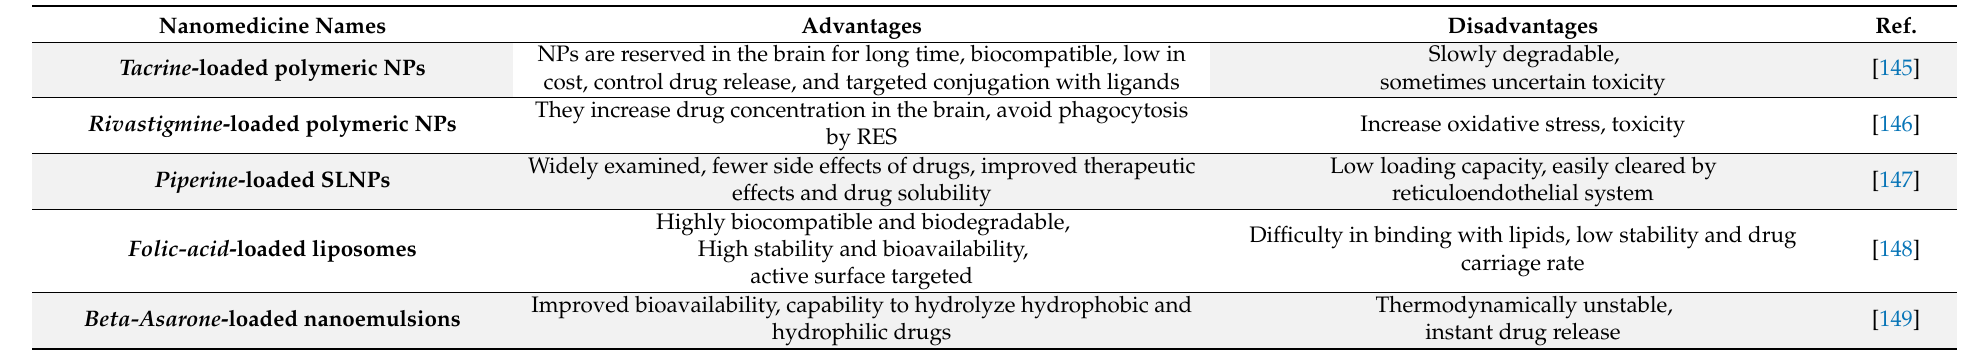
Table 2. Advantages and disadvantages of